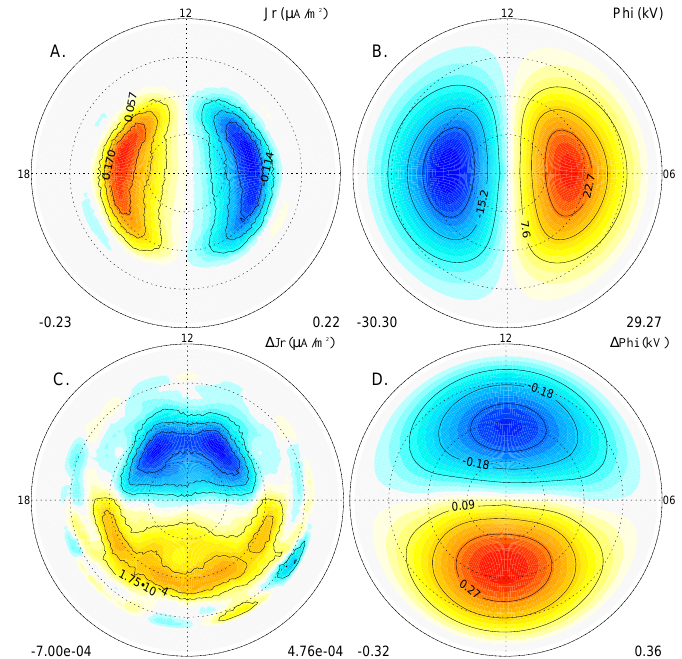
Plate 3. The (A) ionospheric field-aligned current and (B) potential patterns, for a simulation with the Pedersen conductance at 5mho, and the Hall conductance of 0mho. (C) The difference between (a) and the field-aligned current solution with a 10mho uniform Hall conductance and (D) the same for the electic potential. Each plot is in the same coordinate system as Plate 1. Once again, each plot has an independent color scale, while the maximum and minimum values are indicated below the